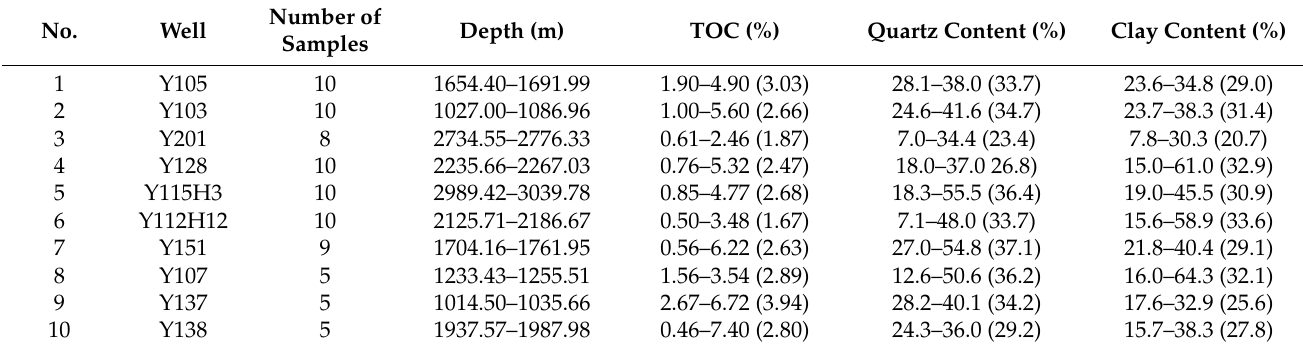
Figure 1. Location of the study area and stratigraphic column of Longmaxi Formation. ( a ) Location of Sichuan Basin in China; ( b ) Zhaotong shale gas demonstration (green dotted line) and the 10 studied well locations (red circles); ( c ) stratigraphic and sublayers division of the Wufeng–Longmaxi Formation shale proposed by PetroChina company. Table 1. The basic information and petrophysical properties of the marine shale